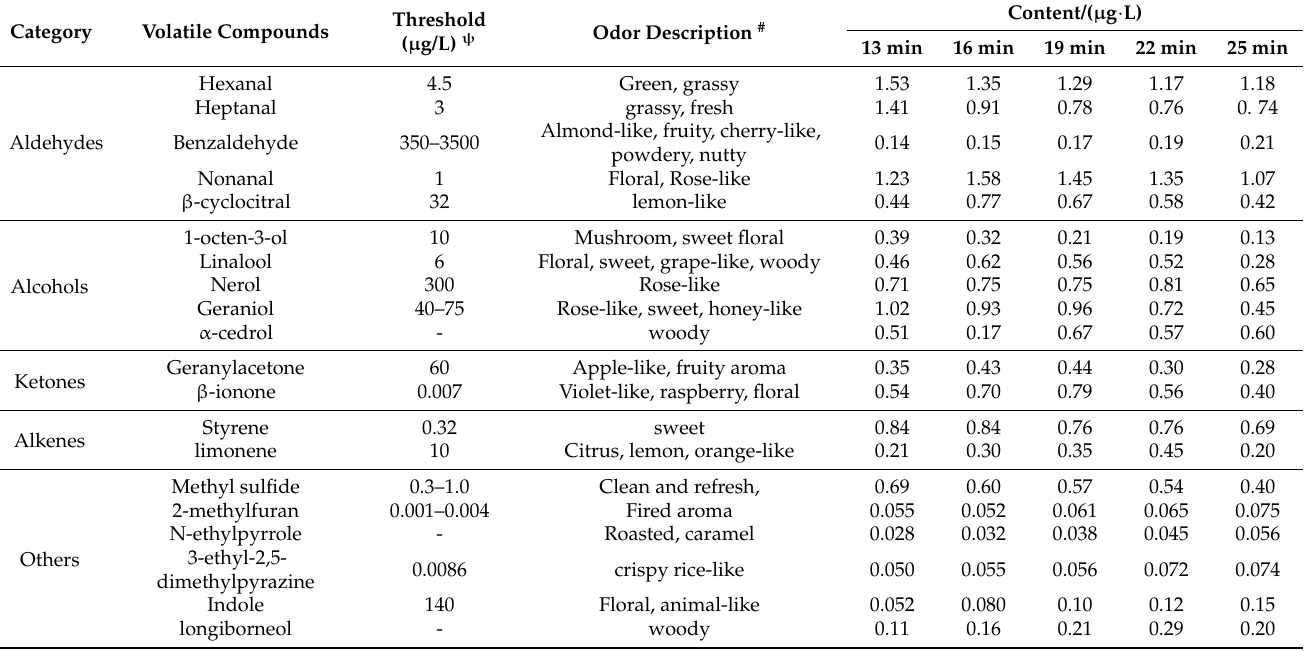
Table 3. Main volatile compounds of the YAYT with different roasting